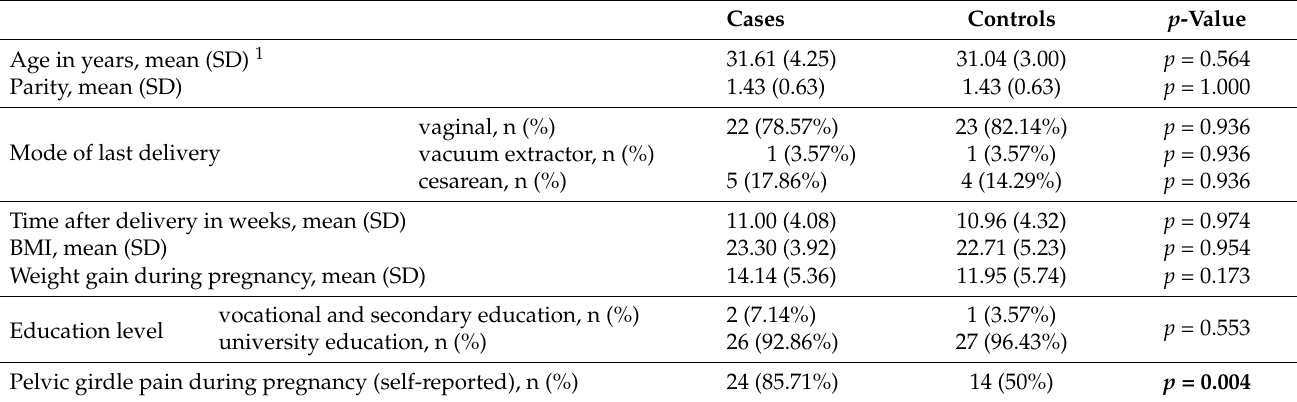
Table 1. Differences between cases with pelvic girdle pain (n = 28) and controls (n =